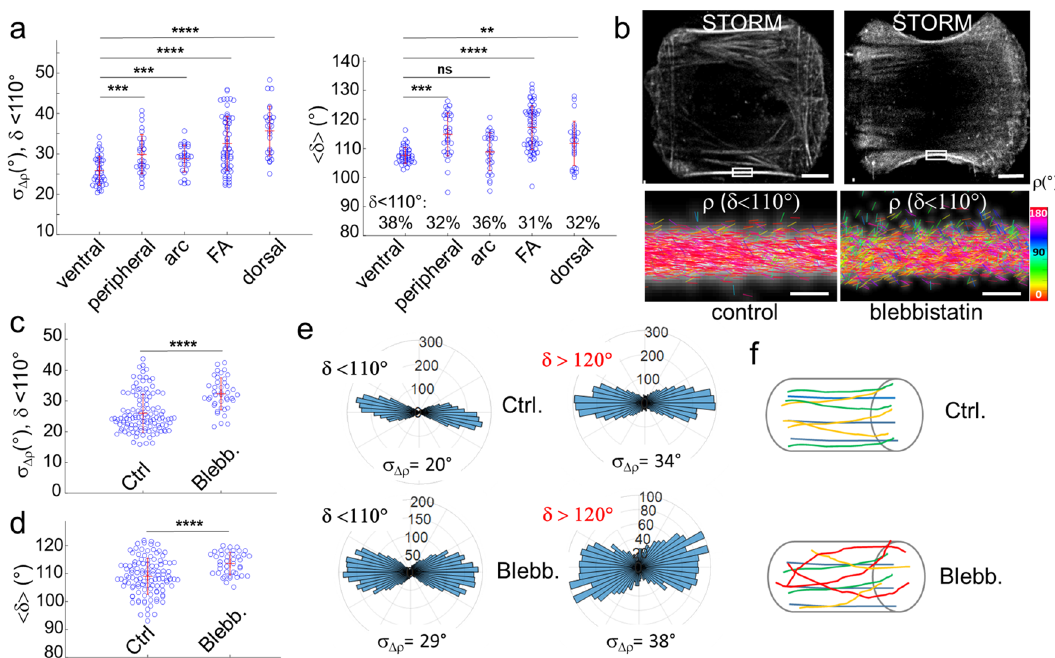
Fig. 4 4polar-STORM imaging of actin fi lament organization in different types of stress fi bers. a (left) σ Δρ ( δ < 110°) and (right) < δ > (all molecules, the percentage of the δ population with δ < 110° is indicated), measured in ROIs on different types of SFs. Eight cells were examined, giving a total number of measured ROIs of: n = 42 (ventral), n = 32 (peripheral), n = 30 (arc), n = 63 (FA), n = 28 (dorsal). The red bars represent mean values ± standard deviation. Statistical signi fi cance: ns ( p > 0.05); ** ( p < 0.01); *** ( p < 0.001); **** ( p < 0.0001) (two-sided unpaired two-sample T-test). p values from top bar to bottom, compared to the ventral SF population: (Left) p = 6.3e − 12, 3.6e − 8, 6.2e − 4, 1.2e − 5, 1055 molecules measured on average per ROI; (right) p = 2.6e − 3, 8.2e − 12, 0.3, 2.6e − 7, 2994 molecules measured on average per ROI. b top: STORM images of control and blebbistatin-treated U2OS cells on micropatterns (see Methods). Scale bars, 6.5 μ m; bottom: 4polar-STORM ρ stick images of zoomed regions (rectangles in the STORM images). Scale bars, 500 nm. Images were repeated on four different cells per condition, with similar results. c , d σ Δρ and < δ > measured in four cells per condition (control, blebbistatin-treated), using in total n = 87 ROIs in control cells and n = 43 ROIs in treated cells. c σ Δρ values ( δ < 110°), p = 3.5e − 8, 2333 molecules measured on average per ROI, ( d ) < δ > values (all δ selected), p = 4.1e − 5, 6376 molecules measured on average per ROI. e Polar-plot histograms of ρ in the zooms shown in ( b ), for δ < 110° (left) and δ > 120° (right). The corresponding σ Δρ values are shown. f Schematic representations of the SFs observed in control and blebbistatin-treated conditions, showing highly aligned actin fi laments in 2D (top) and disorganized fi laments in 3D (bottom). Source data are provided as a Source Data fi